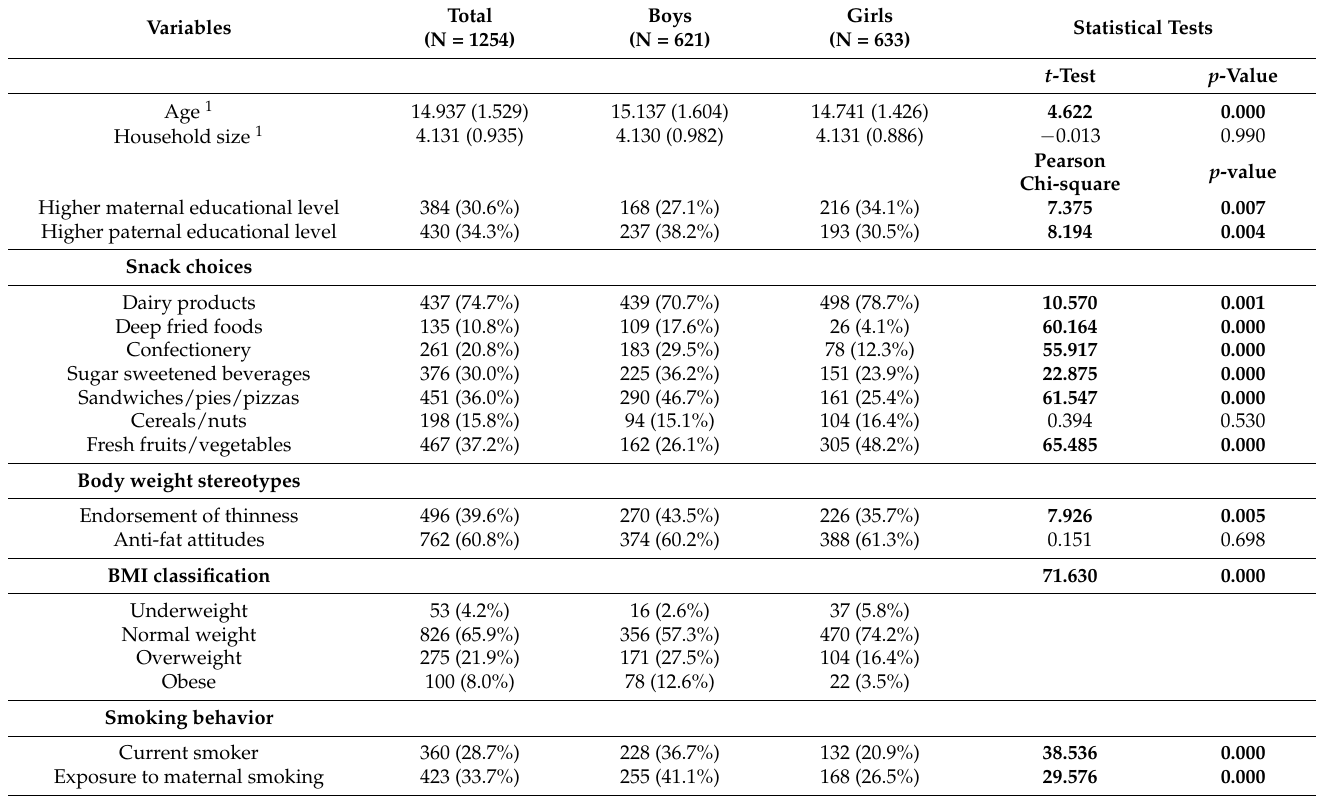
Table 2. Sample characteristics (adolescents 12–19 years